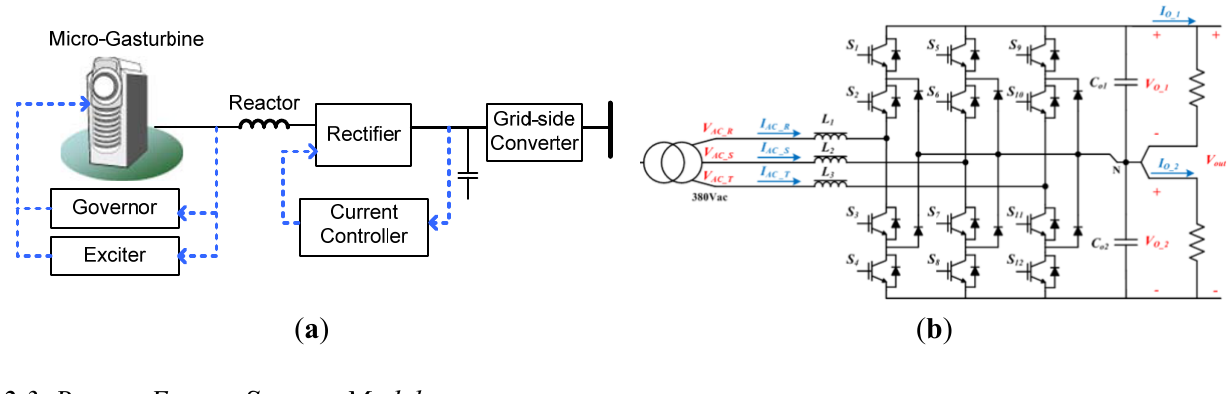
Figure 2. Configuration of MGT and grid-integrate converter: ( a ) Micro-Gas Turbine; ( b ) Three-level NPC-type power converter.